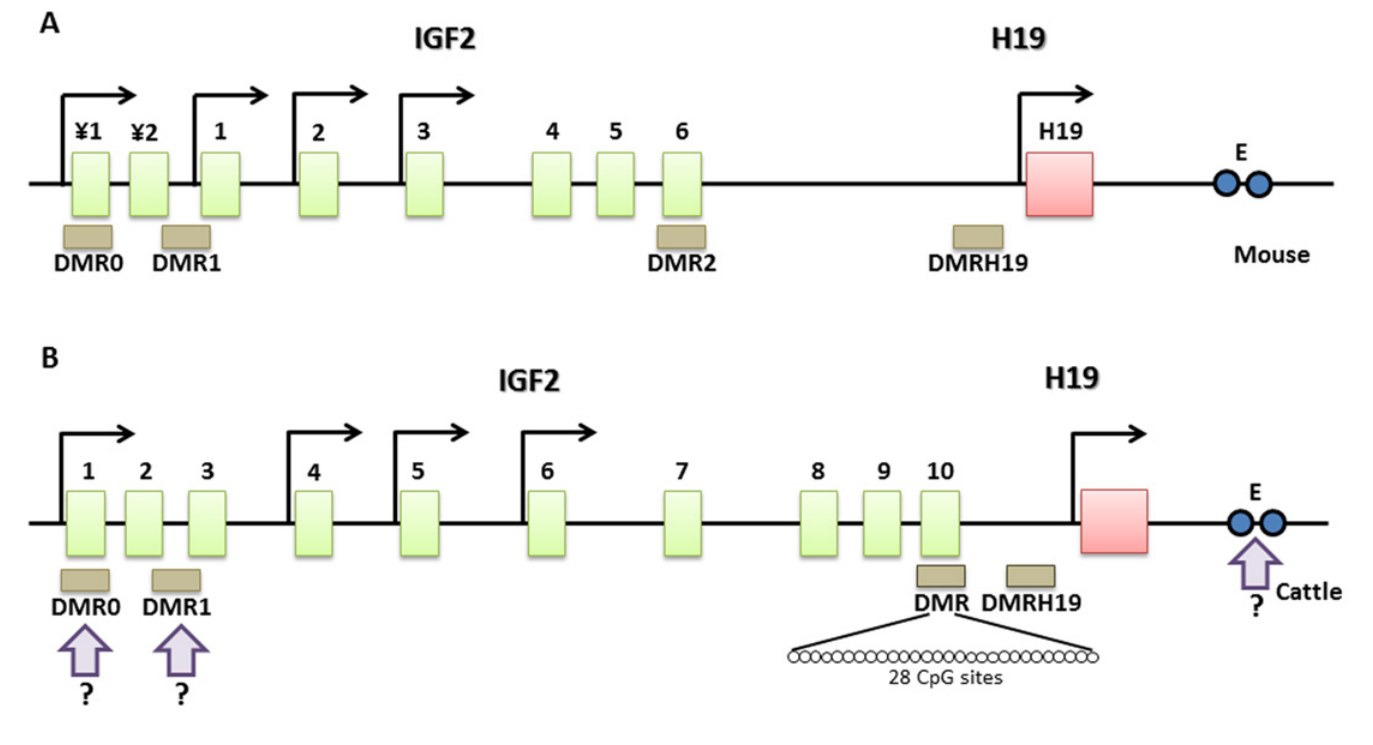
Fig 1. Comparative representation of the mouse and cattle IGF2 genes. Green rectangles represent exons, while pink rectangles represent the H19 gene. Promoter regions are indicated by arrows and differentially methylated regions (DMRs) are represented by brown rectangles. ¥1 and ¥2 represent pseudo-exons 1 and 2, respectively, in the mouse igf2 gene. The CpG island analyzed in this study is located in IGF2 exon 10. White circles represent each individual CpG that was analyzed. The enhancer (E) that is involved in controlling the H19 and igf2 genes is represented by two blue circles. Question marks means that the information has not been completely confirmed in cattle.